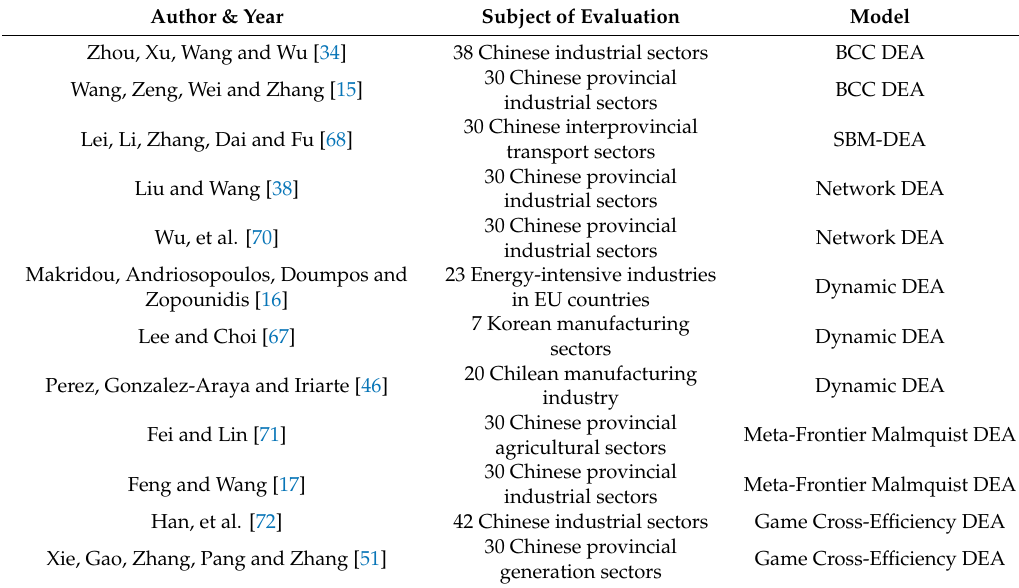
Table 3. Energy e ffi ciency evaluation of